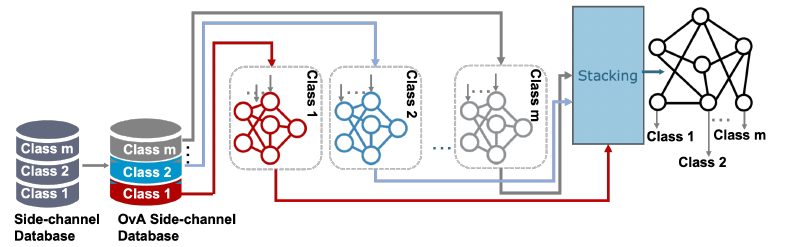
Figure 4: Schematic of the NEAT algorithm configured to deliver a stacked model.